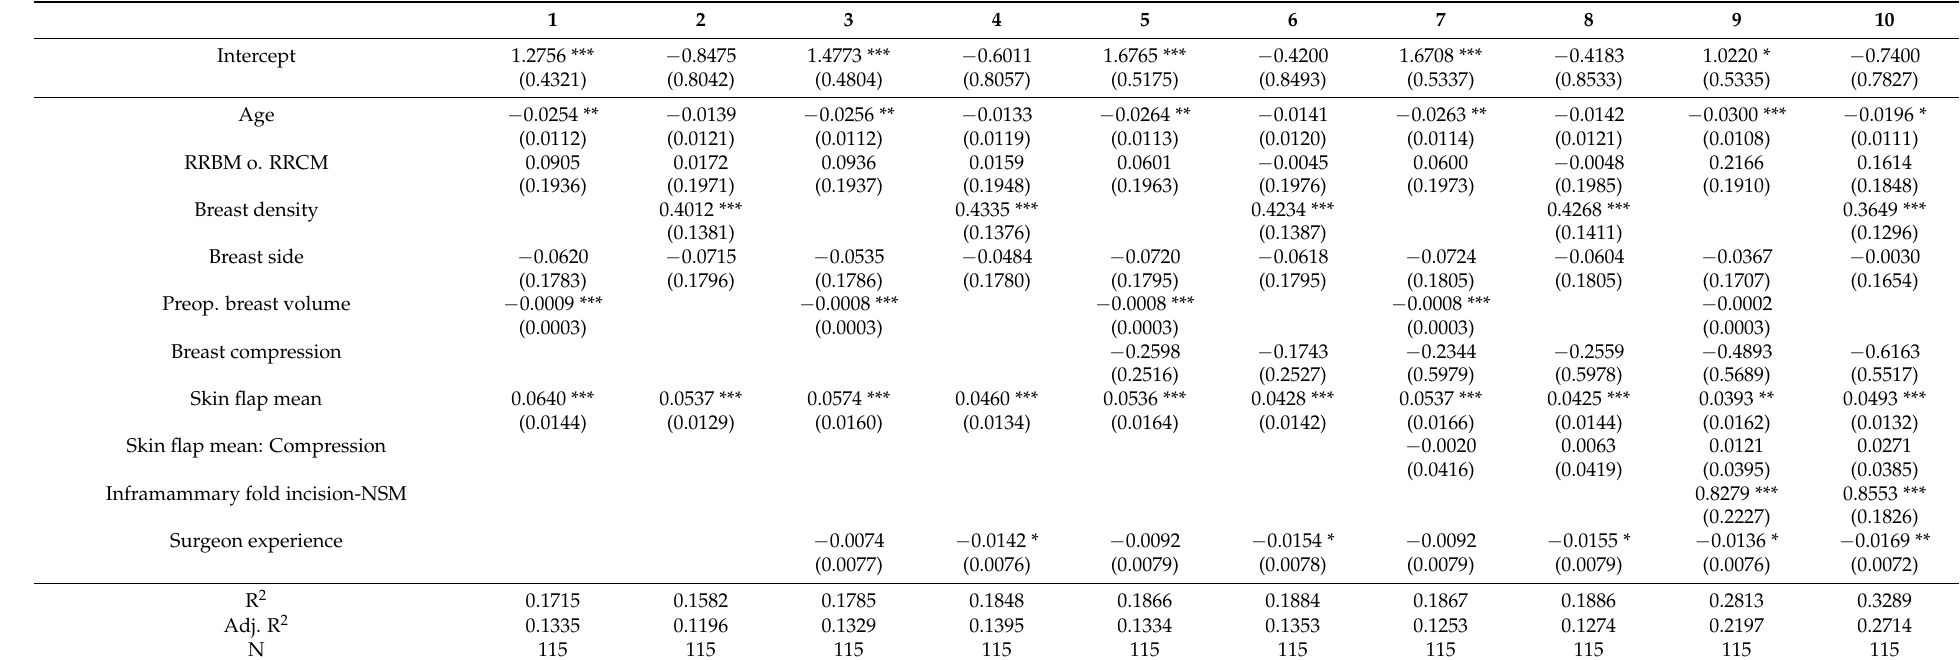
Table 6. Multivariate regression—residual glandular tissue